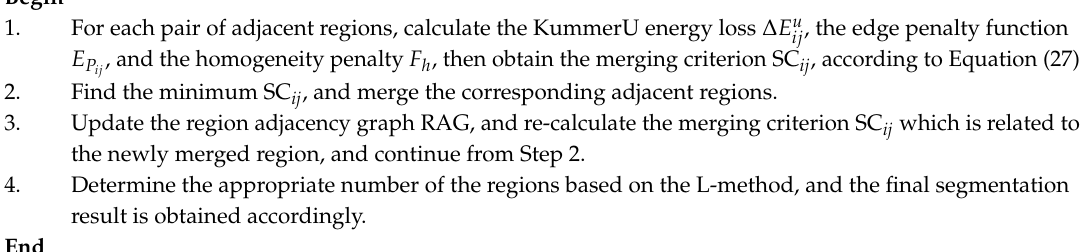
Algorithm 1: KUMS iterative merging.